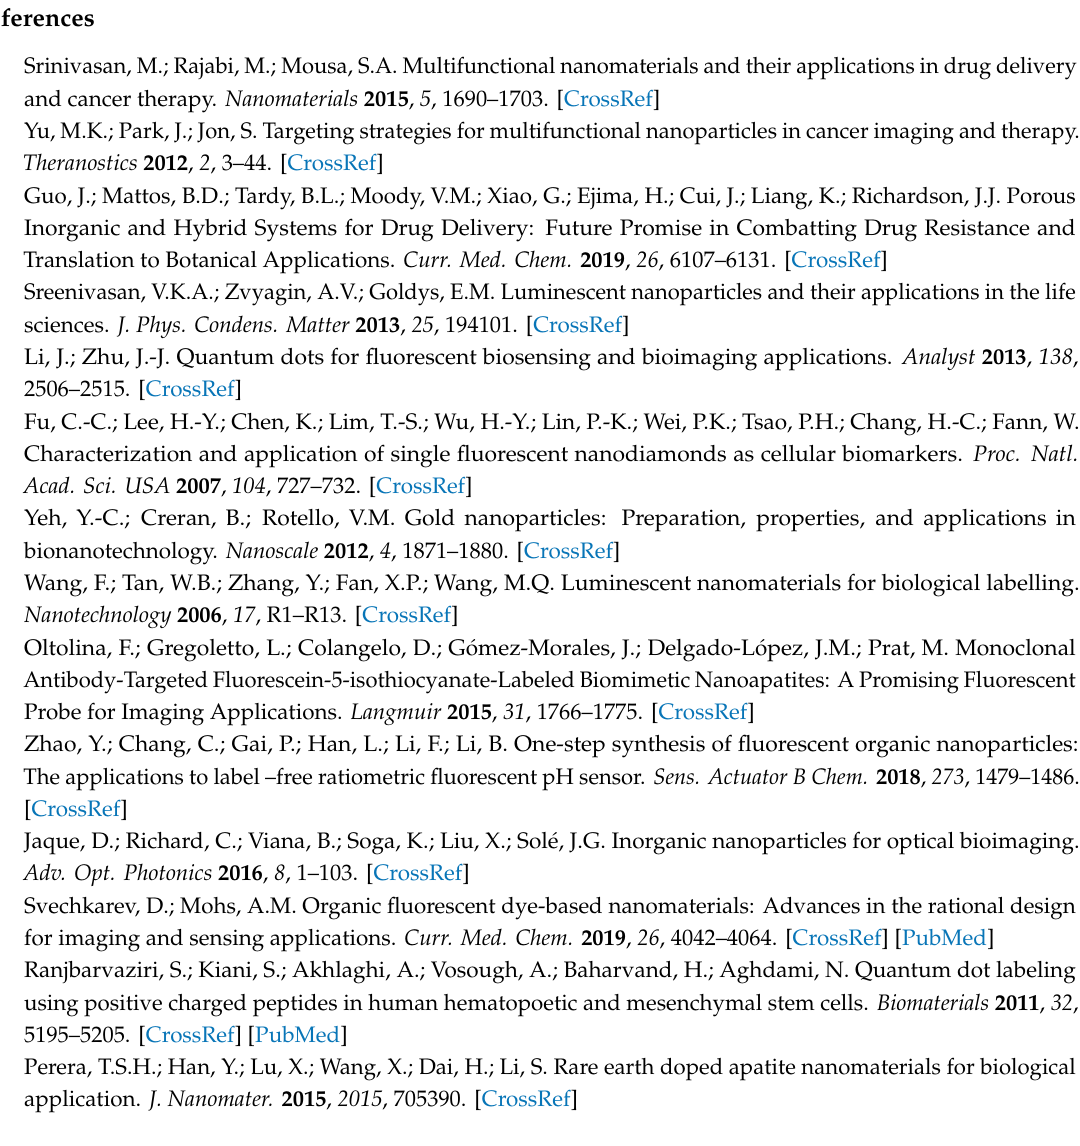
equilibrium Doxo concentration. Figure S8: Luminescence decay curve of Eu:cit-cAp / Doxo nanoparticles with varying concentration of Doxo suspended in HEPES bu ff er at pH = 7.4 and 25 ◦ C. Figure S9: Variation of the apparent quenching constant with the concentration of the